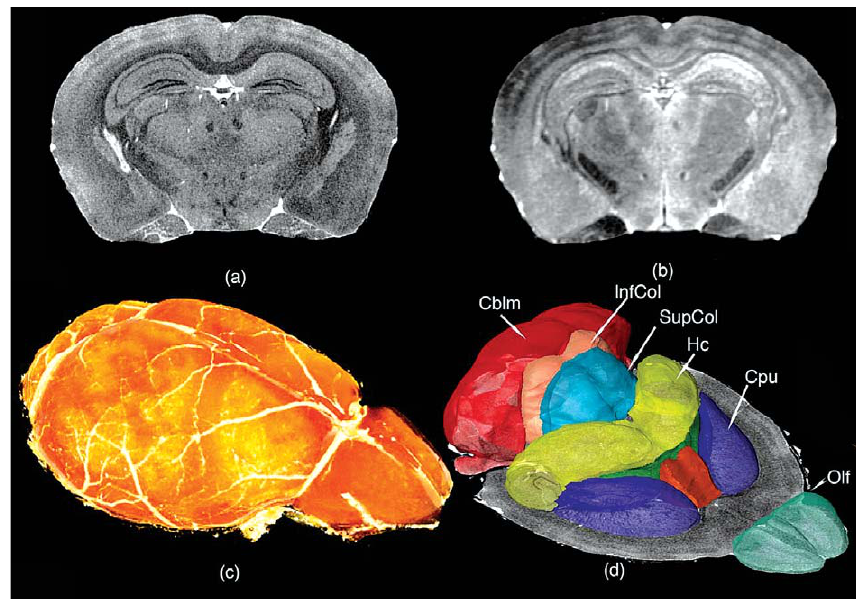
Fig. 11. (a) T 1 -weighted and (b) T 2 -weighted images of the actively stained mouse brain offer rich contrast to differentiate and segment brain regions, and can help determine the genetic basis of their volume variation; (c) Volume rendered T 1 image showing the brain surface; (d) Surface rendering of structures that have been segmented and quantified, including olfactory areas (Olf), striatum (CPu), septal nuclei, fimbria, hippocampus (Hc), superior and inferior colliculi (SupCol, InfCol), and cerebellum (Cblm). Reprinted with permission from [5,